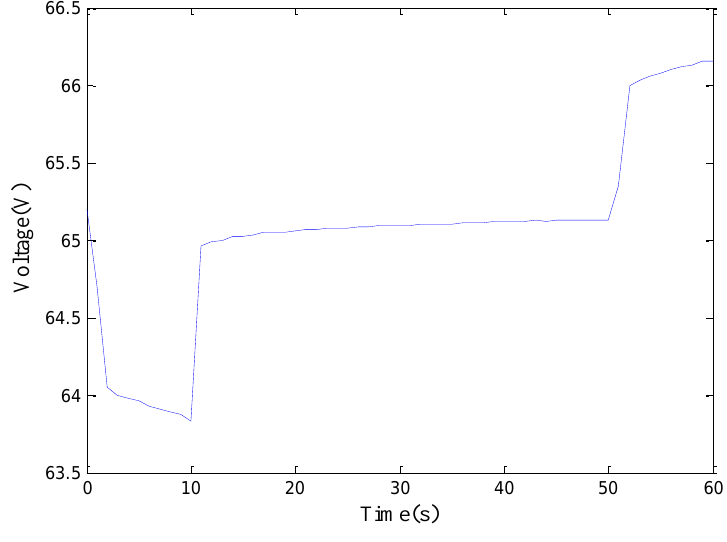
Figure 4. Battery voltage profile in HPPC test at 90%